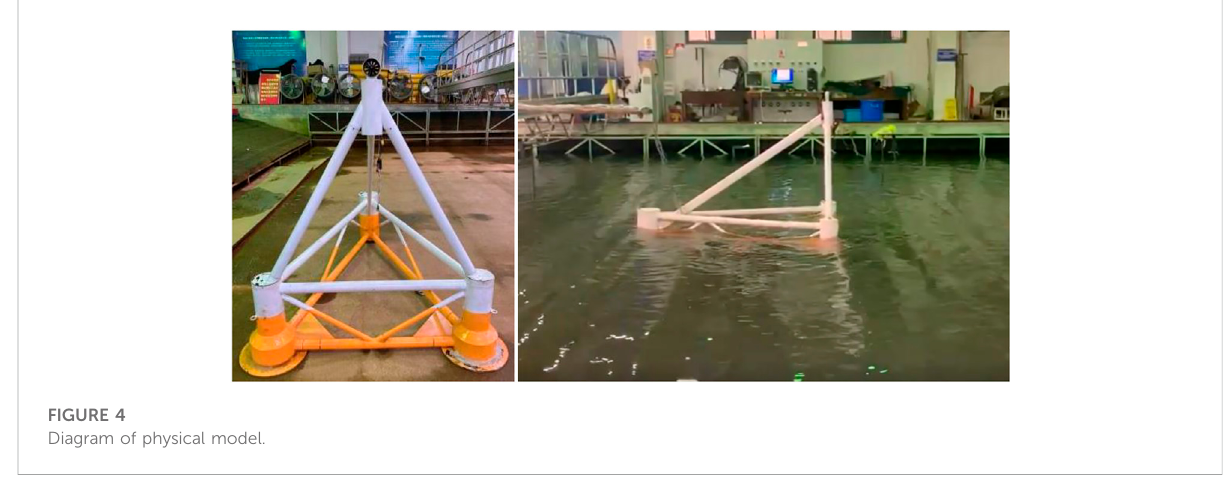
FIGURE 4 Diagram of physical model.